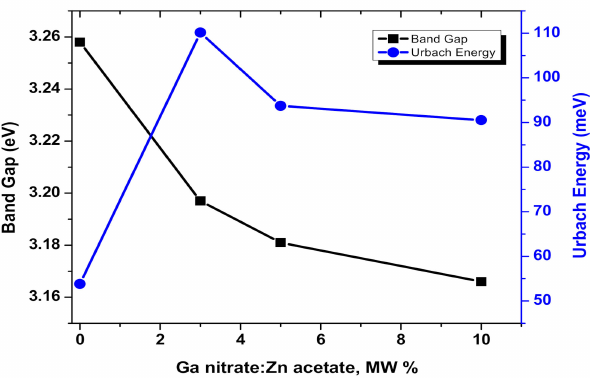
Figure 10. Band gap and Urbach energy variations as a function of Ga nitrate molarity weight percentage for the investigated Ga-doped ZnO